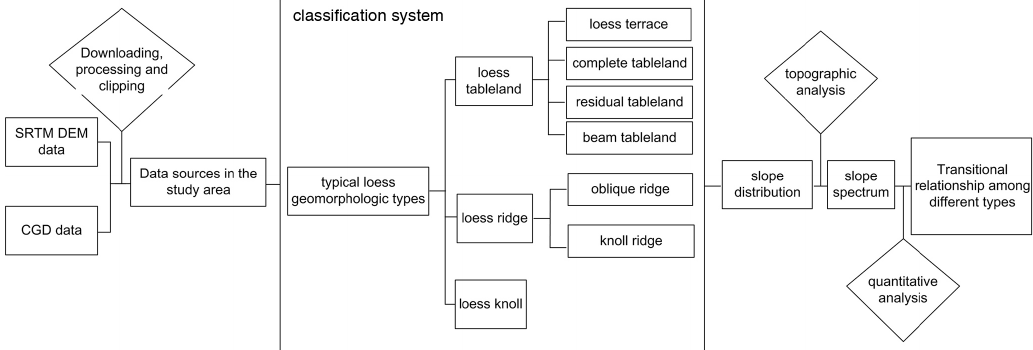
Figure 1. The workflows in this research.